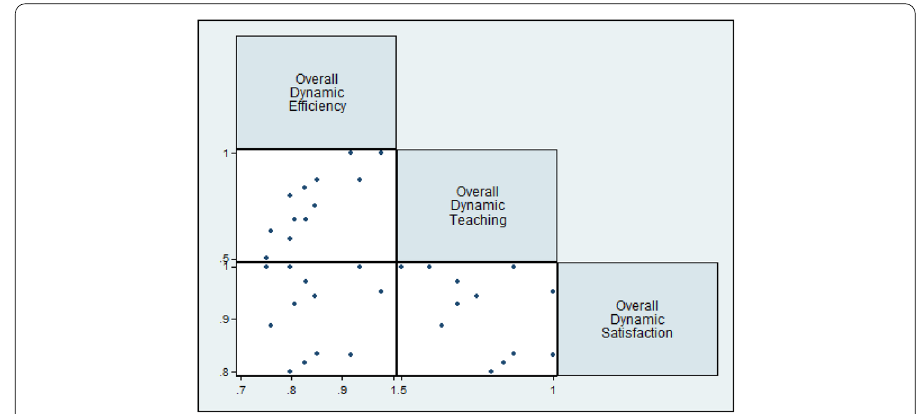
Fig. 5 Scatter plot matrix of the training efficiency in